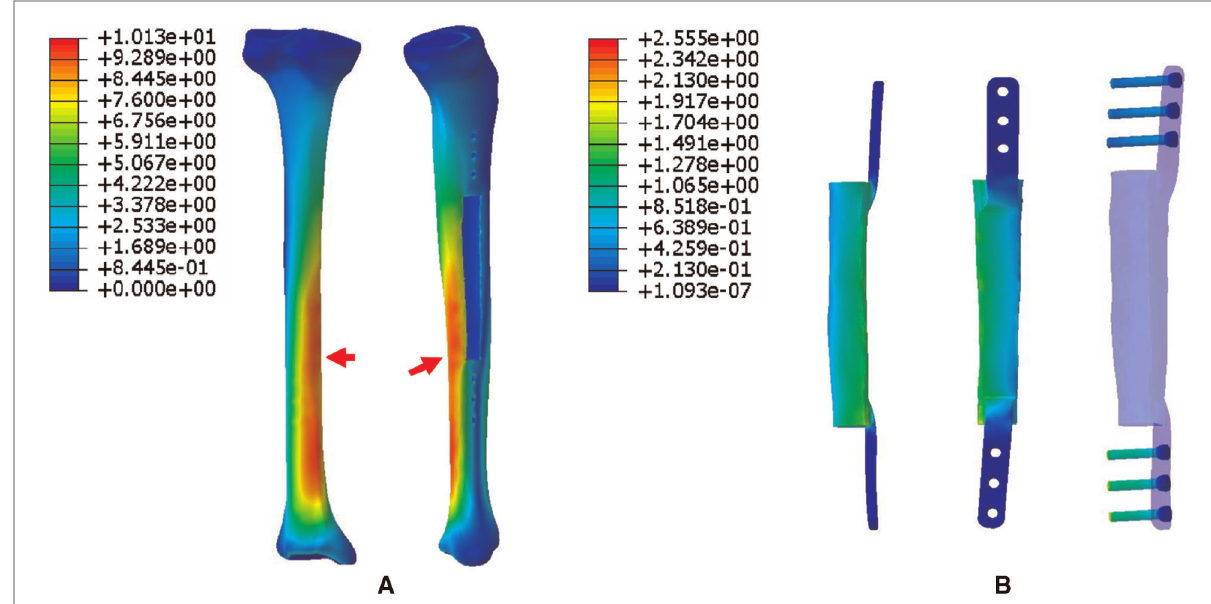
FIGURE 9 Von Mises stress distribution in Mode V, the red arrows indicate the maximum stress concentration. ( A ) Stress distribution of the integral structure. ( B ) Stress distribution of the prosthesis and internal fi